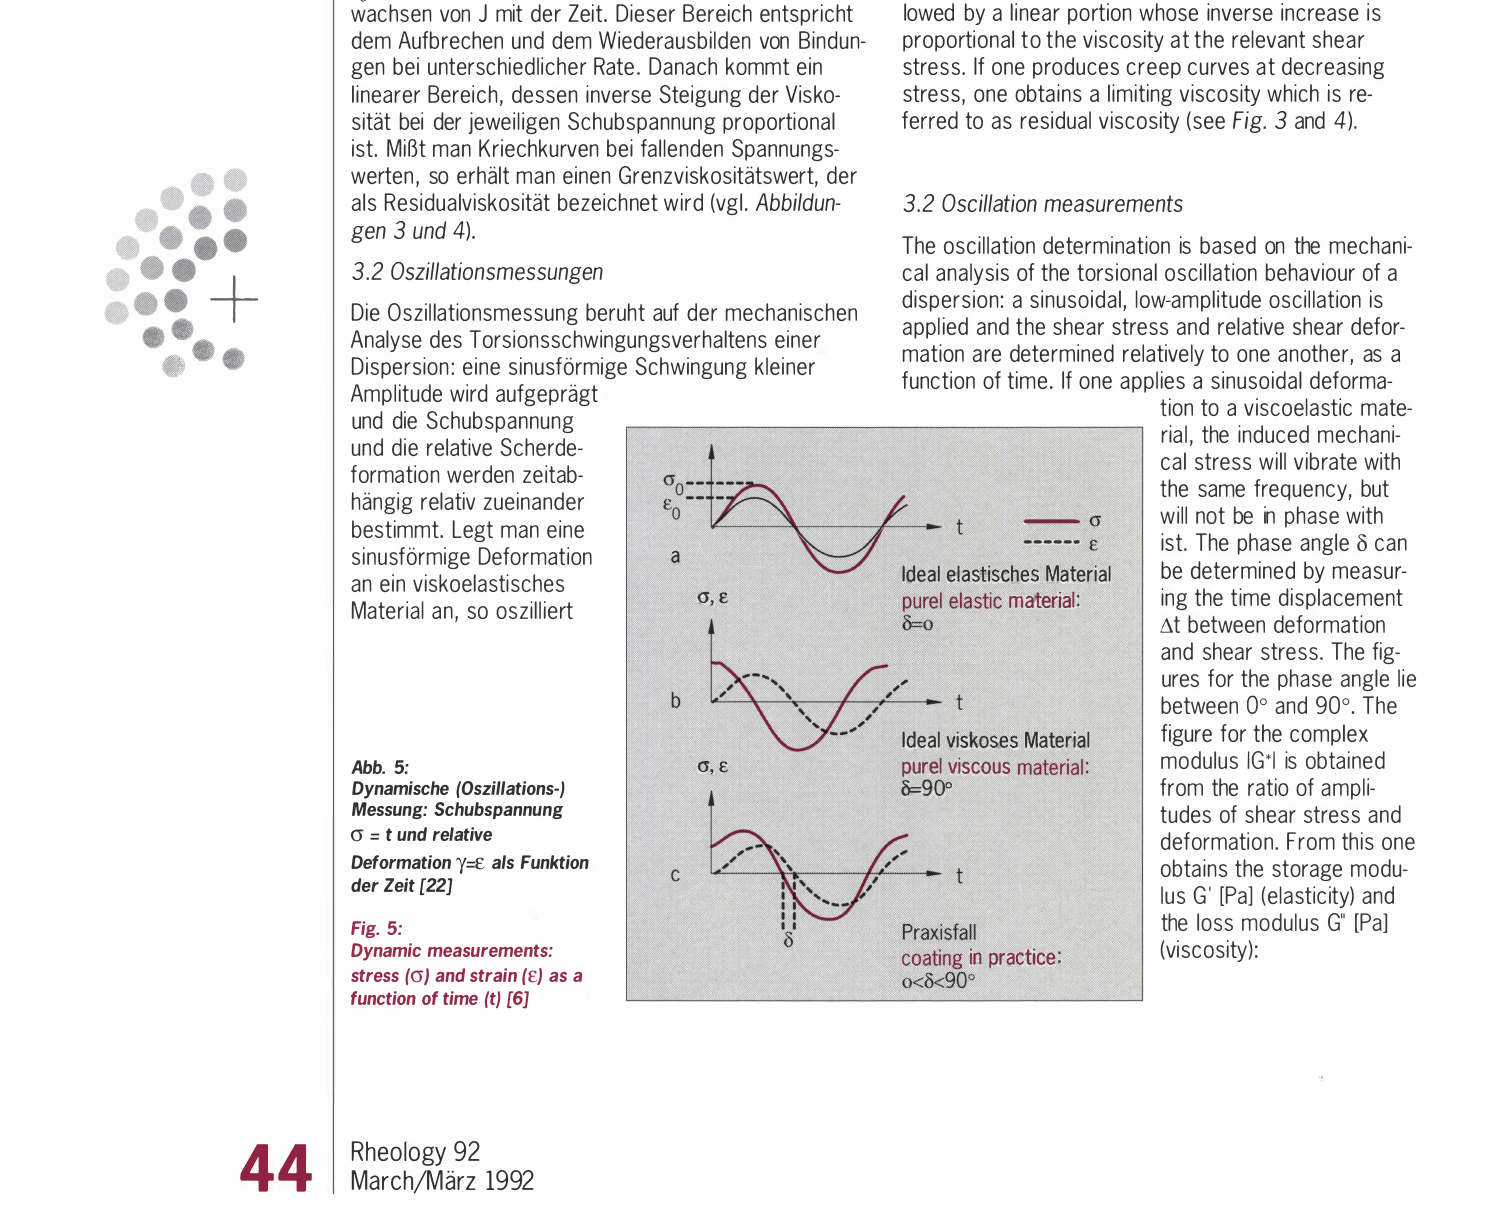
Fig. 5: Dynamic measurements: stress (<J) and strain function of time (t)